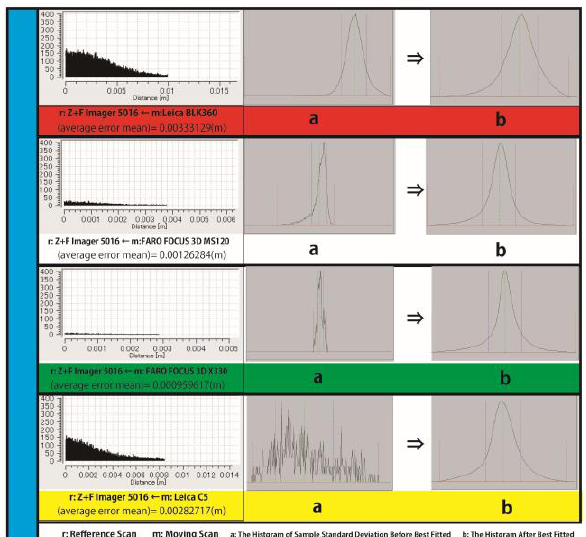
Figure 12: The Results of Aligning (Refference:Leica BLK360), (3D Recnstructor and IMAlign were used)